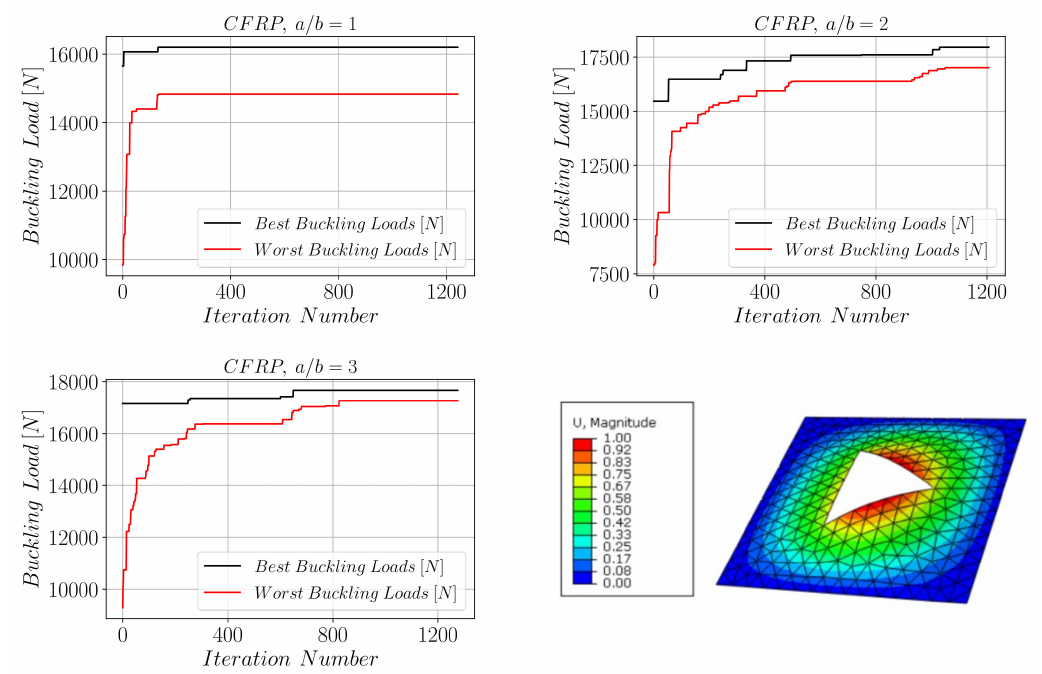
Figure 12. The development of the best and worst-performing stacking sequences in the harmony search optimization for all aspect ratios with triangular cut-out under uniaxial compression parallel to the longer